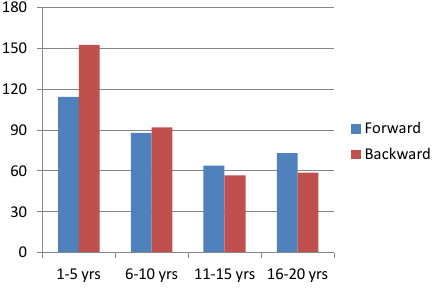
Figure 1. Overview of childhood intakes of BPA for four age ranges, and for forward and backward approaches. Values shown are mean intakes expressed in